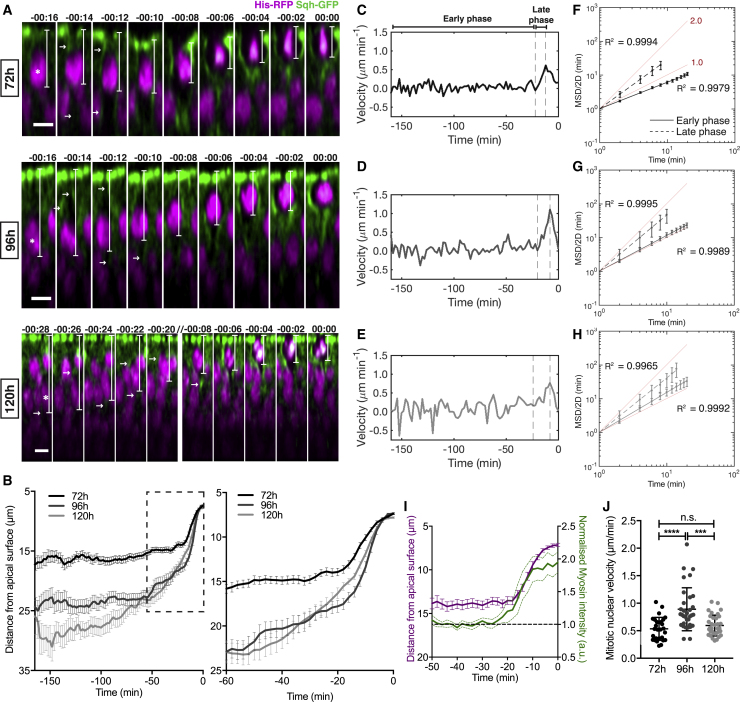
Mitotic Nuclear Dynamics Depend on Tissue Architecture(A) Time-lapse images of mitotic nuclear movement for Sqh-GFP, His-RFP wing discs at 72, 96, and 120 h AEL. White lines: measurement of nuclei movement for analysis in (B). Arrows: cortical Sqh-GFP enrichment. Double slash: skipped time steps. 00:00 min represents final metaphase. Scale bars, 5 μm.(B) Average mitotic nuclei track at 72, 96, and 120 h AEL. Inset: transition to directed apical movement. Figures S2A–S2C show individual tracks.(C–E) Average instantaneous nuclear velocity (C, 72 h; D, 96 h; E, 120 h AEL). Early phase, non-directed movement; late phase, directed nuclear movement.(F–H) Log-log plot of MSD/2D versus time lag (F, 72 h; G, 96 h; H, 120 h AEL). Solid line, early phase; dashed line, late phase. Slopes for early and late phases, respectively: 72 h, 0.78 and 1.45; 96 h, 1.06 and 1.66; 120 h, 1.18 and 1.61. R2 values are displayed in each panel. Red lines show lines of slope 1 (corresponding to diffusive movement) and slope 2 (corresponding to ballistic movement).(B–H) n = 28, 33, and 34 nuclear trajectories from 3 (72 h), 3 (96 h), and 4 (120 h) wing discs, respectively.(I) Normalized lateral membrane Sqh-GFP intensity (green) and nucleus distance from apical surface (magenta) for 72 h discs. n = 16 mitotic cells from 3 wing discs.(J) Mitotic nuclear velocity for each track calculated from onset of apical movement and cortical Sqh-GFP enrichment, to most-apical metaphase. For 72, 96, and 120 h discs, mean onset of upward movement was −15.4, −13.8, and −18.5 min, and duration of upward movement was 11.1, 10.7, and 15.7 min, respectively. n = 28, 33, and 34 nuclear trajectories from 3 (72 h), 3 (96 h), and 4 (120 h) wing discs, respectively.Statistical significance: (J), one-way ANOVA. n.s., p > 0.05; ∗∗∗p < 0.001, ∗∗∗∗p < 0.0001. Error bars: (B) and (I) (magenta), mean ± SEM; (F)–(I) (green), mean ± 95% confidence intervals; (J), mean ± SD.